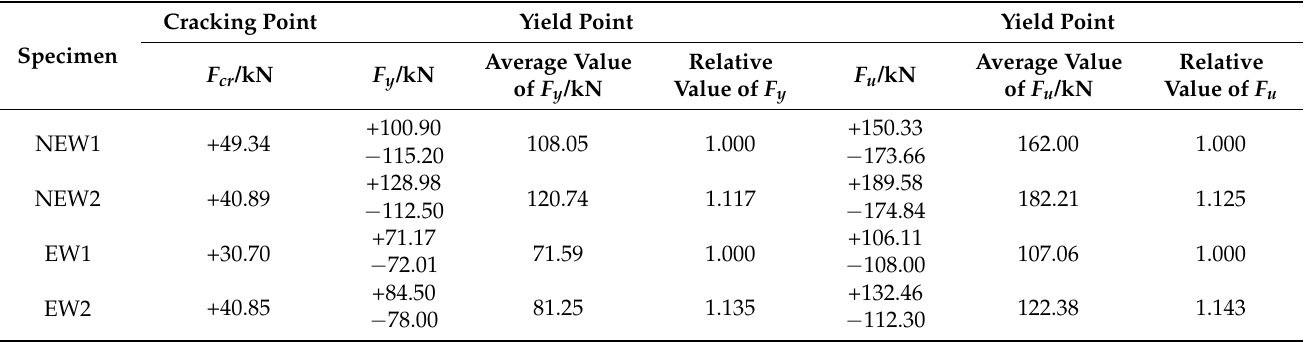
Table 4. Test results of characteristic points.